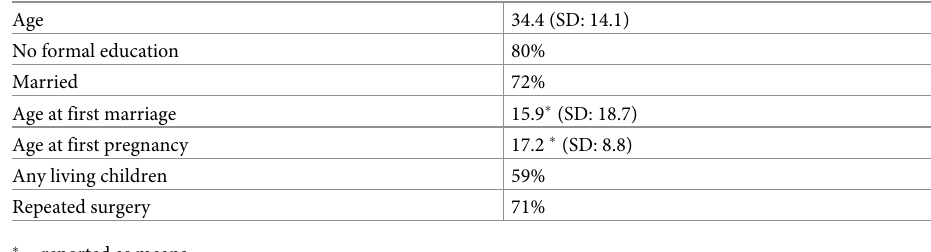
Table 1. Description of the population (n = 207).